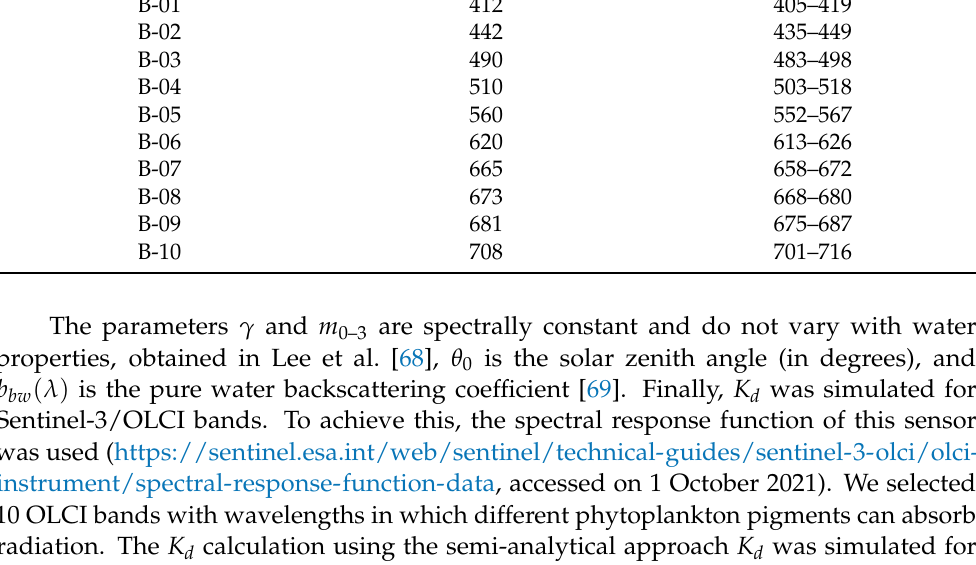
Table 1. Summary of Sentinel3 OLCI bands used. Central wavelength (CW), band width (BW). Bands CW (nm) BW (nm)